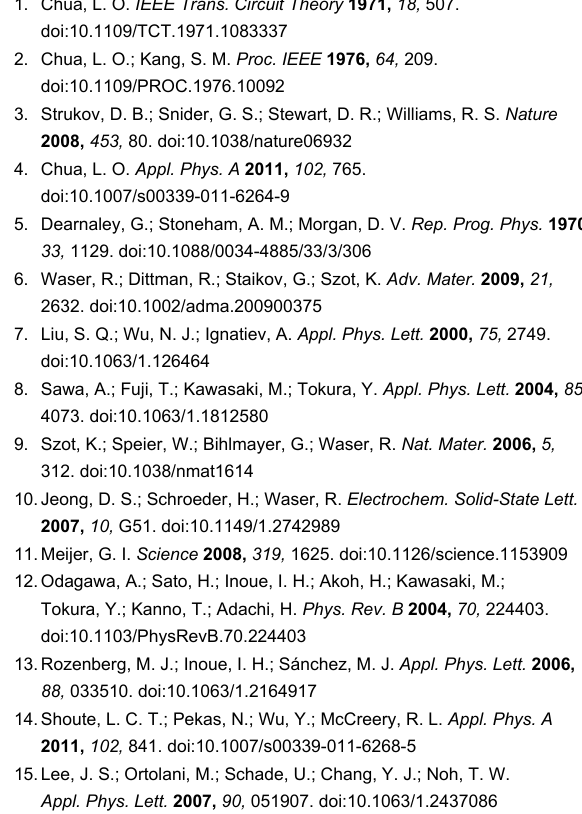
electrode, as seen in Figure 5a and Figure 5b. These grain size distributions were observed to be uniform within the junction, roughly 20 μ m away at the Si 3 N 4 window edge, and over the Si substrate outside of the window (as checked by scanning elec- tron microscopy). This strongly suggests that the grain growth was initiated by self-heating in the thin film electrode